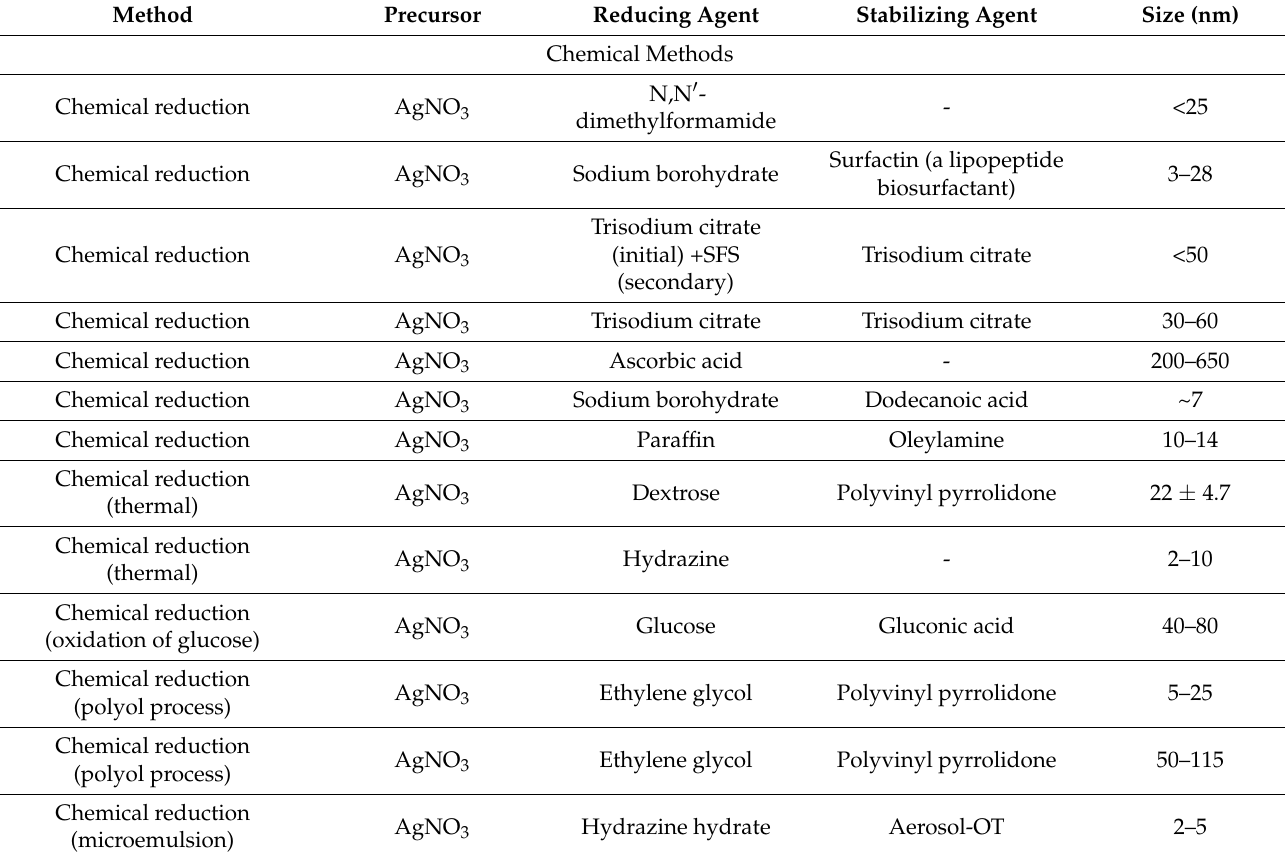
Table 1. Important physical, chemical, and photochemical methods used for the synthesis and stabilization of AgNPs [15].